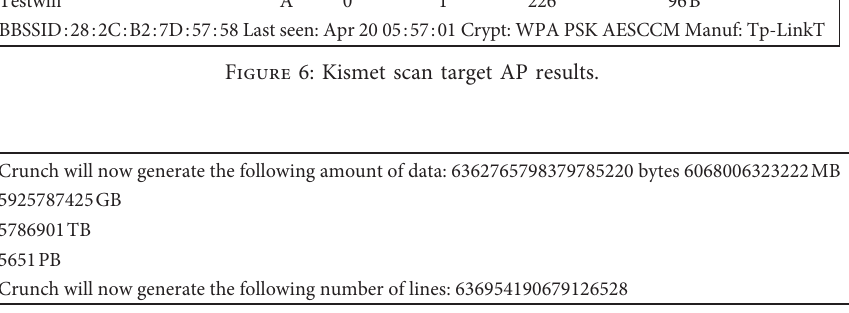
Figure 7: Crunch generates a brute force dictionary.